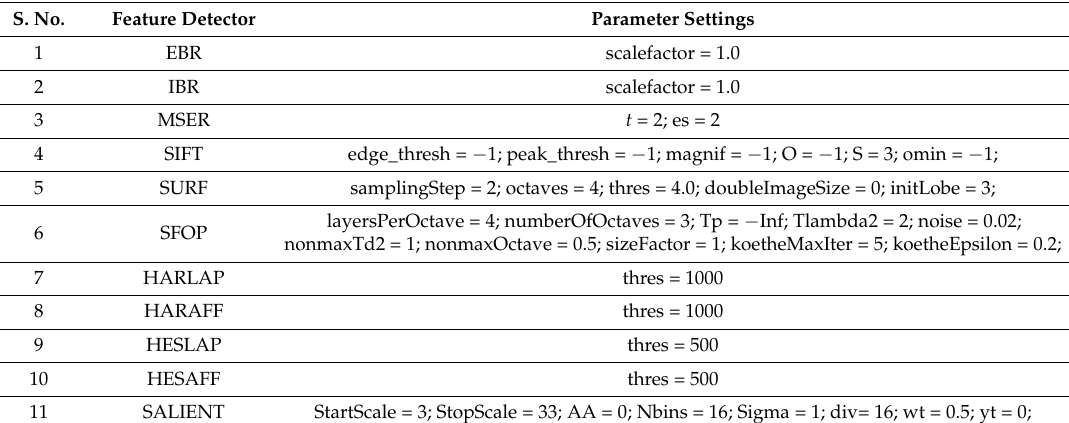
Table 1. Parameter settings for various feature